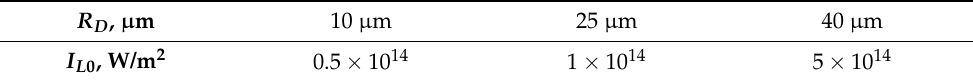
Table 1. Droplet radius and intensity range for the case of pulsed laser